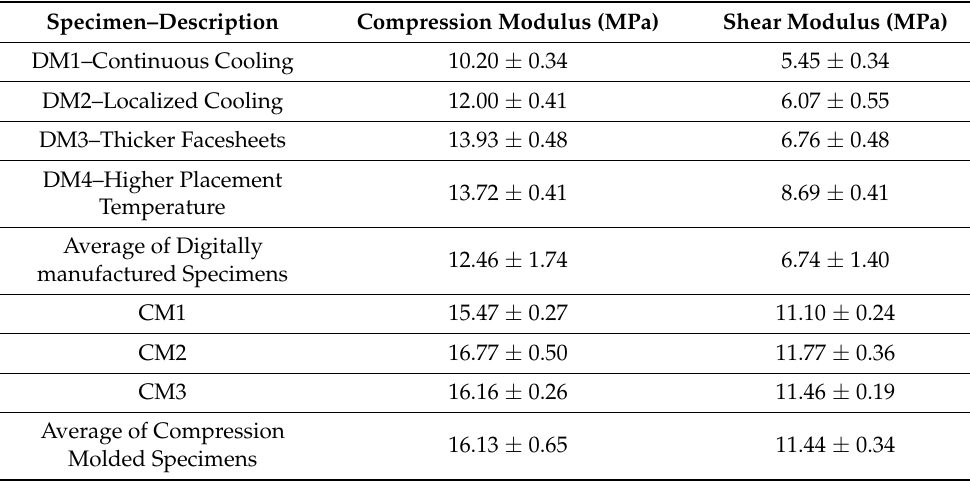
Table 2. Compression Modulus by Manufacturing Method.